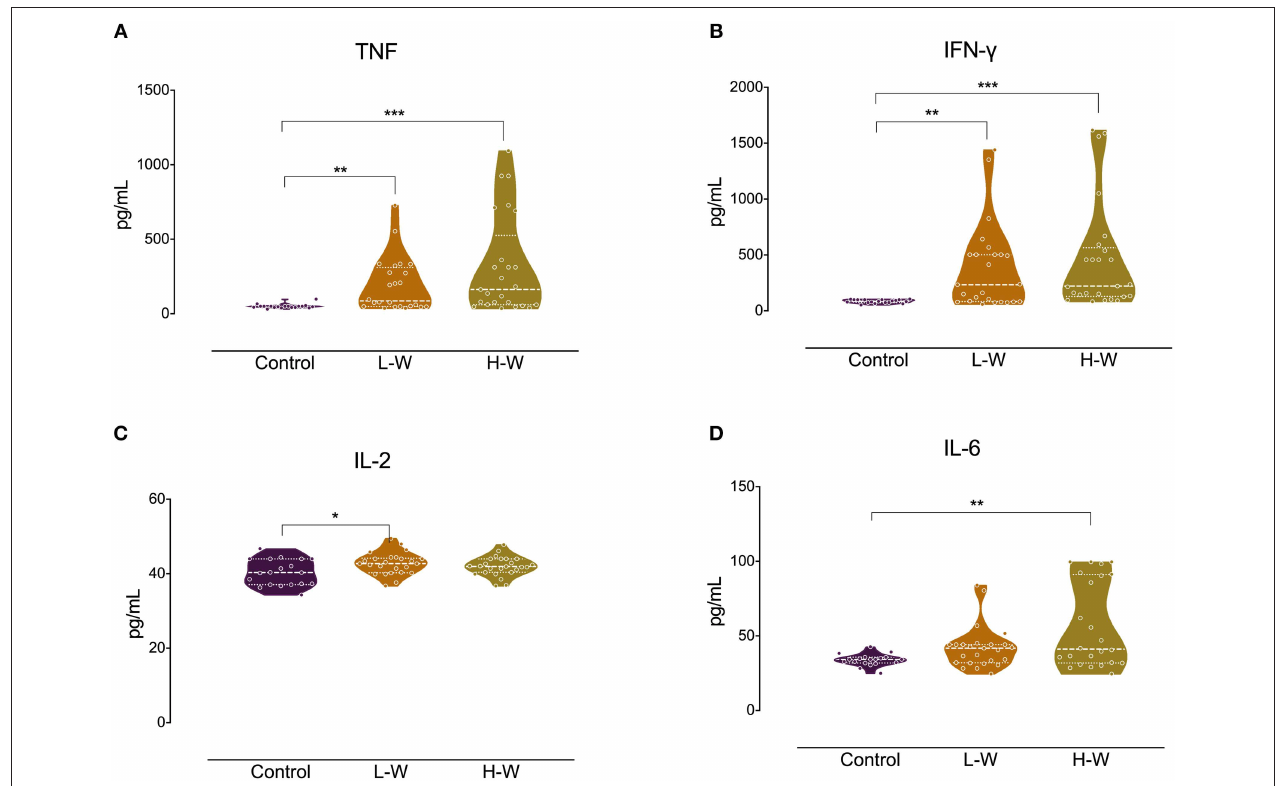
FIGURE 1 | Th-1 cytokines after in vitro stimulation in women with CUD and healthy controls. PBMCs were seeded in 96-well plate and stimulated with phytohemagglutinin (1%) for 72h. Cell supernatants collected from women with CUD had higher levels of TNF (A) and IFN- γ (B) than controls. Only L-W group cells shown increased release of IL-2 in comparison to controls (C) . Only H-W group cells showed higher levels of IL-6 compared to controls (D) . Kruskal–Wallis test was performed for TNF, IFN- γ , and IL-6 statistical analyses; data are shown as median with interquartile range. ANOVA followed by Bonferroni was used to IL-2 statistical analysis. Data are shown as mean ± SD. Statistical significant group differences are indicated * p < 0.05, ** p < 0.01, and *** p < 0.001.